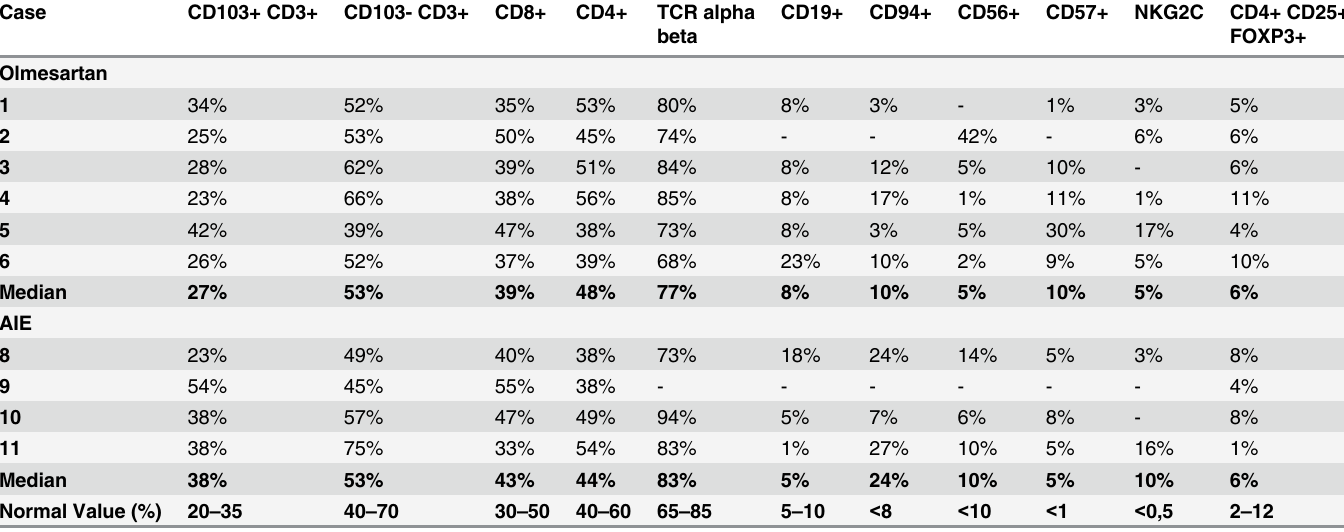
Table 3. Phenotype of lamina propria intestinal